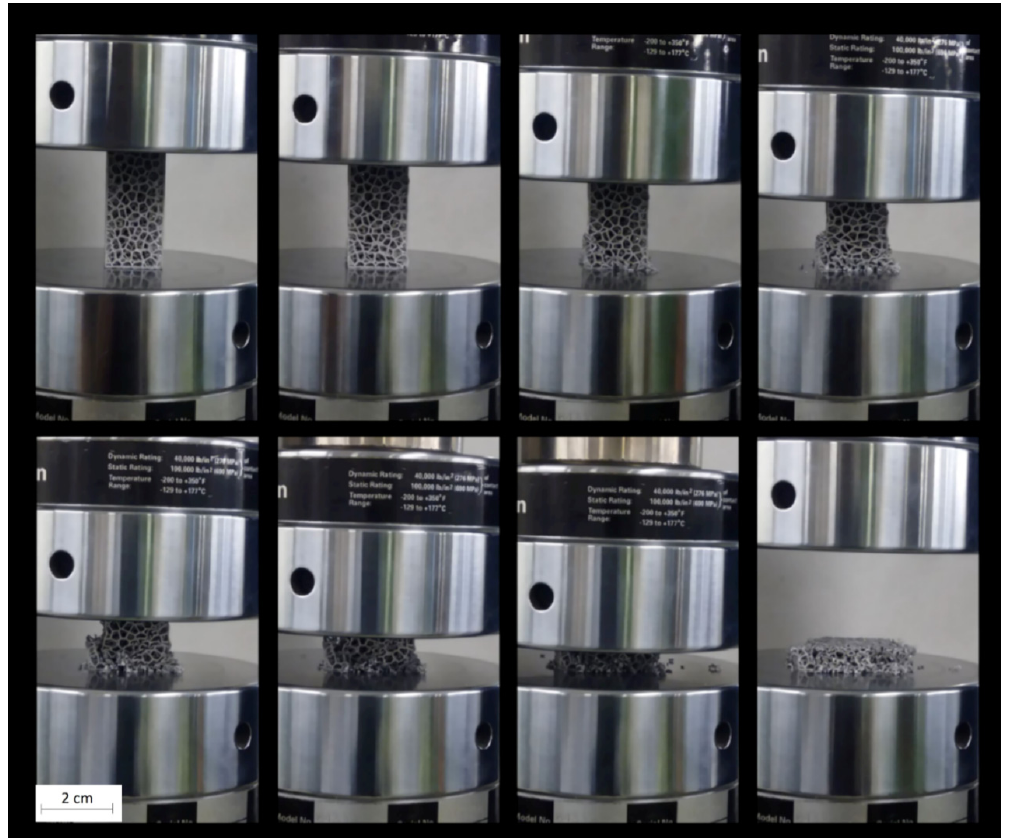
Figure 5. Frames from compression test of 10 PPI designed metal foam specimen.